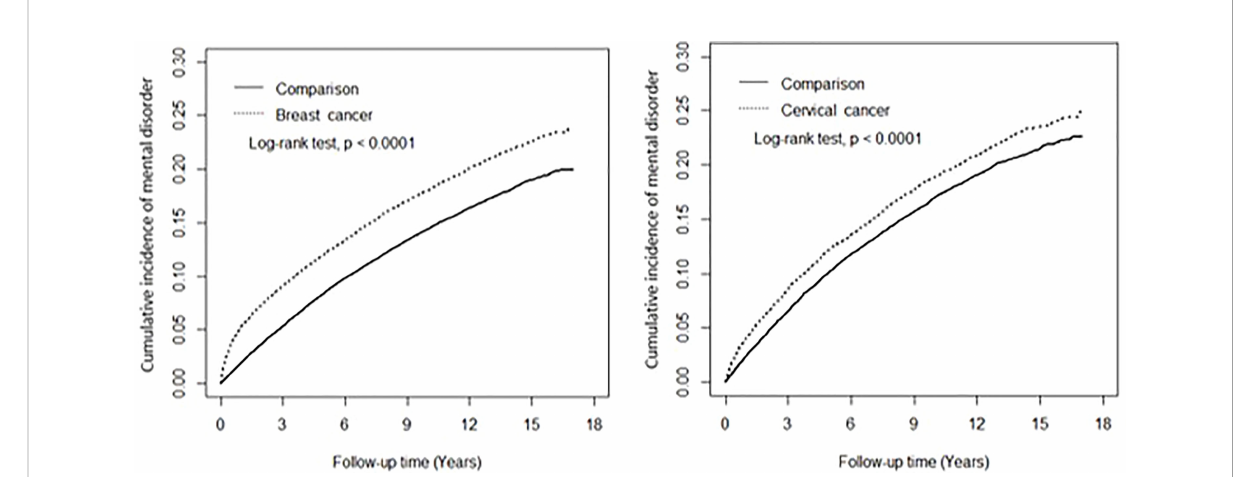
FIGURE 2 Cumulative incident anxiety and depression combined among study cohorts.